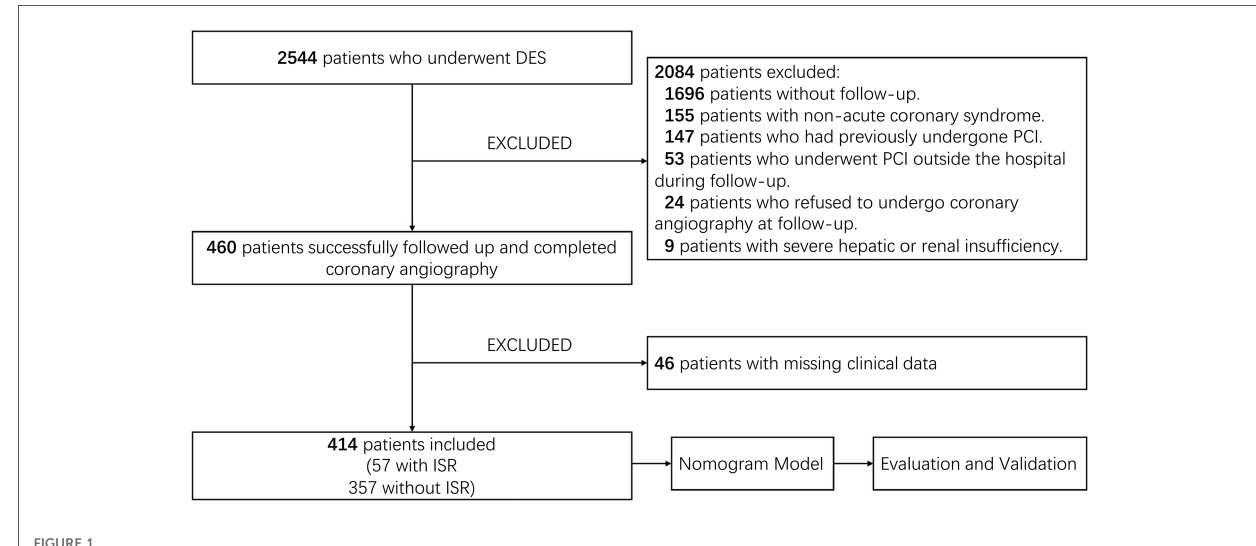
FIGURE 1 Flowchart of this